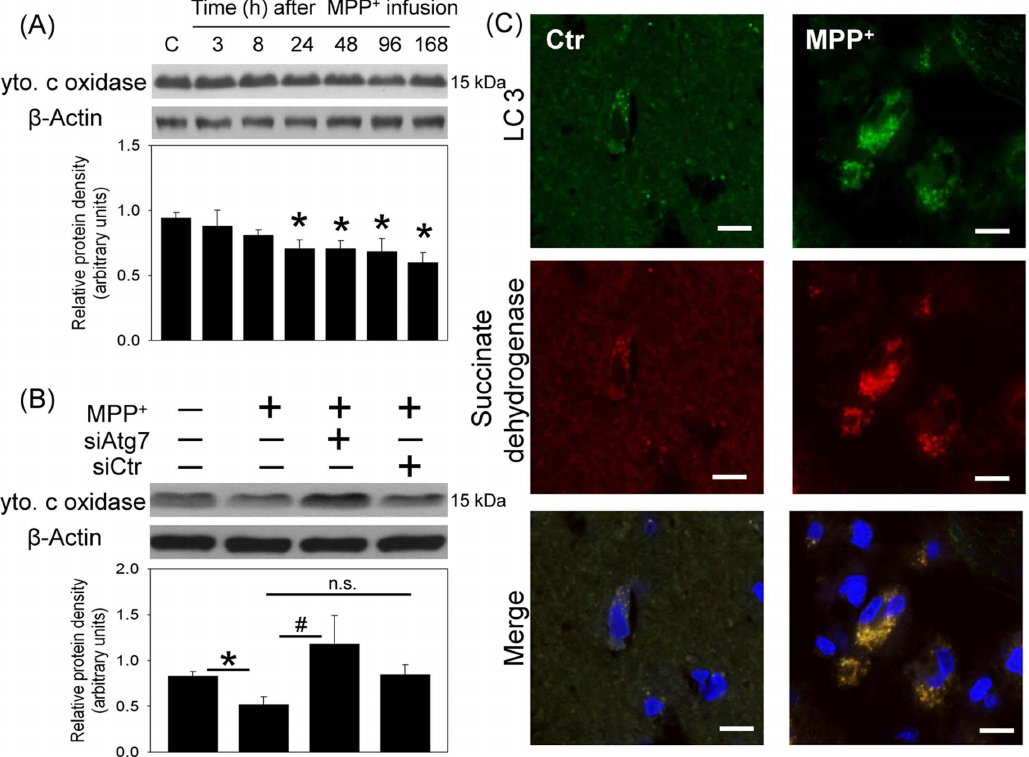
Figure 4. Effect of MPP + on mitochondria content in the nigrostriatal dopaminergic system of rat brain. Intranigral infusion of MPP + (3 m g/ m l) was performed in the anesthetized rats. Rats were sacrificed at the indicated times. (A) Time-dependent effects of MPP + on cytochrome c oxidase levels in the substantia nigra (SN) were studied using Western blot assay. Values are the mean 6 S.E.M. ( n =5/group). *P , 0.05 in the MPP + - treated groups compared with the control groups by one-way analysis of variance (one-way ANOVA) and followed by the LSD test as post-hoc method. (B) Intranigral infusion of Atg7siRNA was performed 4 days prior to intranigral infusion of MPP + (3 m g/ m l) in chloral hydrate-anesthetized rats. Rats were sacrificed 30 h after intranigral infusion of MPP + . The levels of cytochrome c oxidase in SN were measured using Western blot assay. Each lane contained 25 m g protein for the experiments. Graphs show statistical results from relative optical density of bands on the blots estimated by Image J software. Values are the mean 6 S.E.M. (n=4/group). * P , 0.05 in the MPP + -infused SN compared with the intact SN, # P , 0.05 in Atg7siRNA transfected and MPP + -infused SN compared with MPP + -infused SN, n.s. for not significant by Kruskal-Wallis test and followed by Mann-Whitney U test as post-hoc method. (C) Representative immunostaining shows co-localization of LC3 (green) and succinate dehydrogenase (red) in the MPP + -infused SN. Nuclear staining was indicated by blue. Results were repeated with independent experiments.